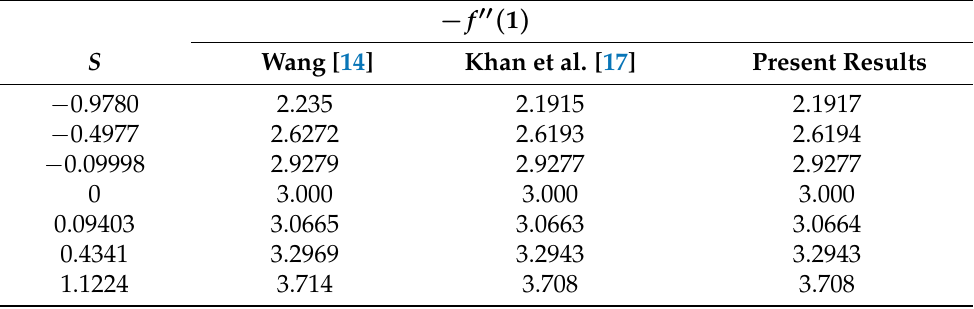
Table 1. Numerical outputs of − f (cid:48)(cid:48) ( 1 ) for S as λ 1 → ∞ , Da → ∞ , De = N b = 10 − 10 , Ha = γ = Ec = δ = N t = R = 0 and Pr = Le = 1.